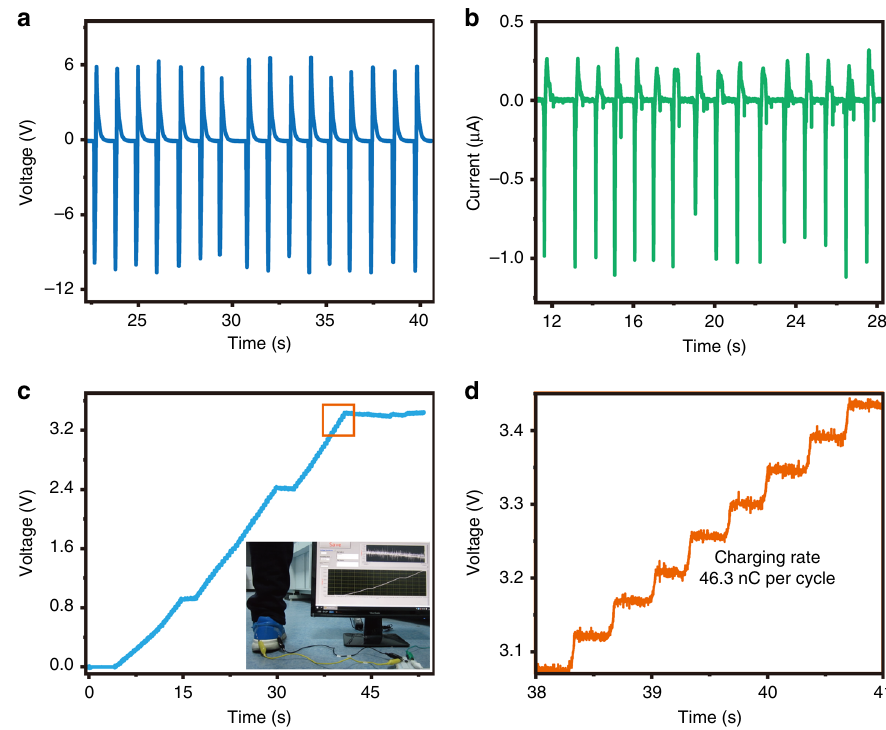
Fig. 6 Application of the IENG on harvesting biomechanical energy. a , b Output voltage and output current signals of IENG driven by human walking. c The corresponding charging curve for a 1 μ F capacitor after recti fi ed. Inserted image shows real scene of charging process. d An enlarged view of the area marked by orange square in c . The corresponding charging rate is 46.3 nC per